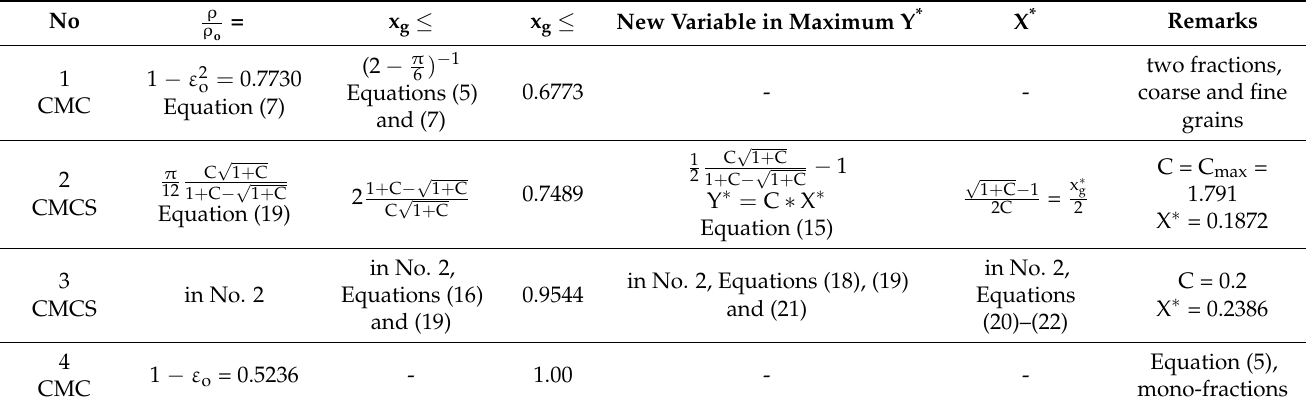
= 1 − ε o , π 6 6 ρ d